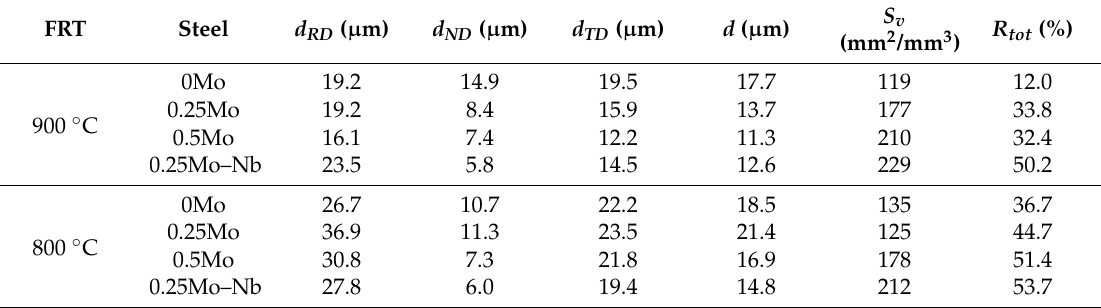
Table 4. Average austenite grain sizes in three principal directions and corresponding d , S v , and R tot estimated for different finish rolling temperatures